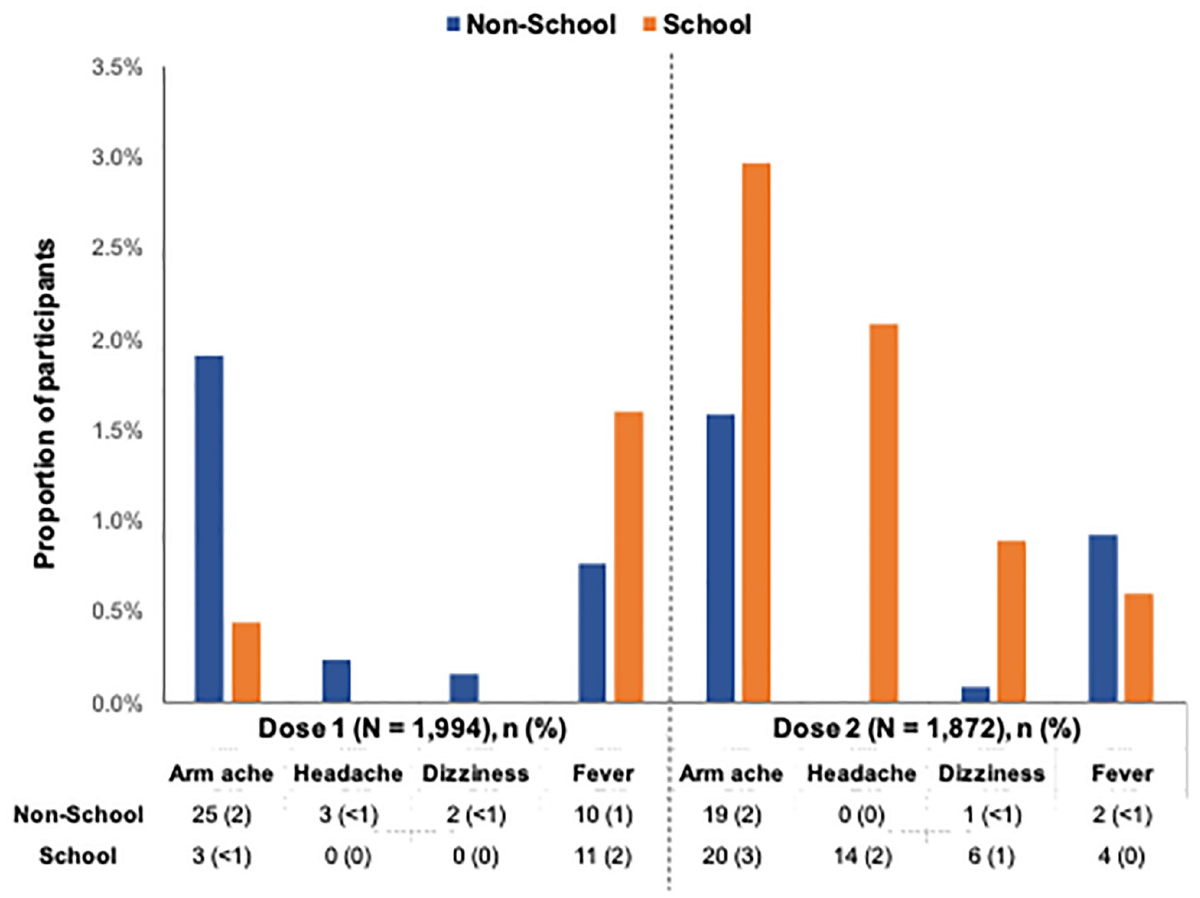
Fig 1. Side effects within two days among participants with at least 1 dose of the HPV vaccine by cohort. a,b a Only 55 participants (non-school:41, school: 14) and 66 participants (non-school: 22, school: 44) reported specific side effects at dose 1 and dose 2, respectively. However, a total of 50 and 157 participants reported malaise within 2 days at dose 1 and dose 2, respectively. b A non-prespecified event reported by one participant in the non- school cohort was allergic reaction after